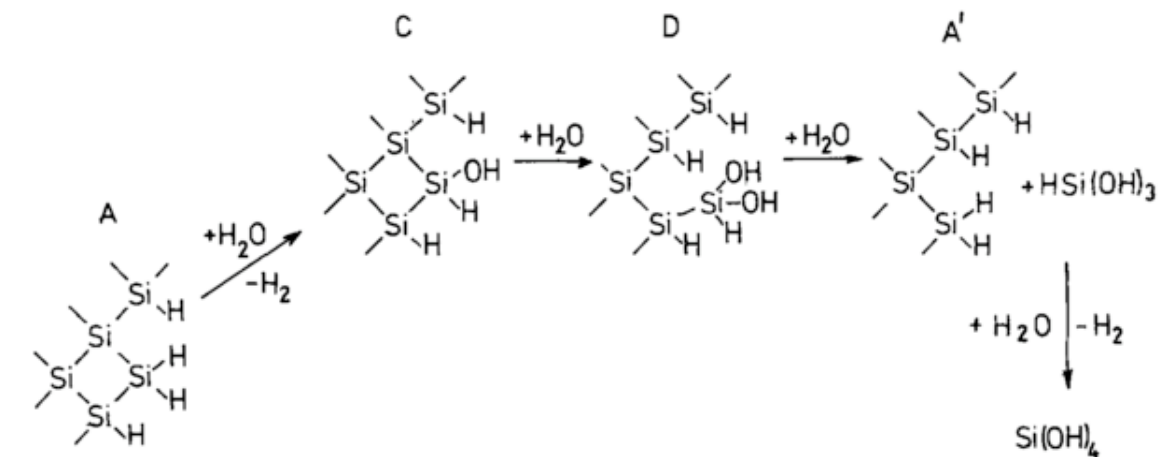
Figure 28. Main reaction path for the chemical dissolution of Si. Reprinted with permission from Reference [94] Copyright 1993 IOP.